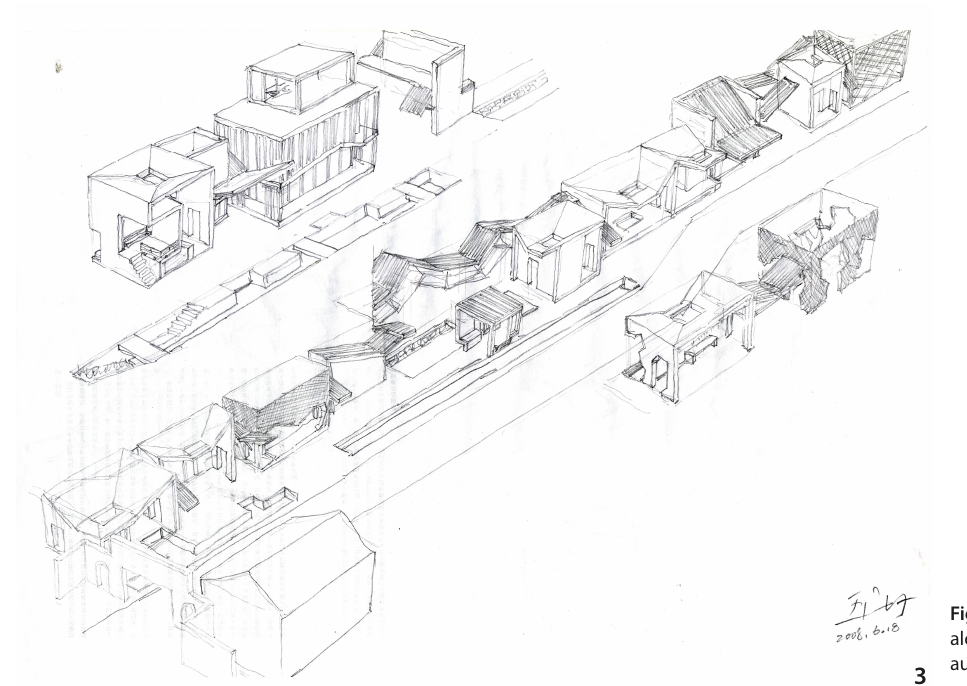
Figure 3 Sketch of buildings along the street (Drawn by the